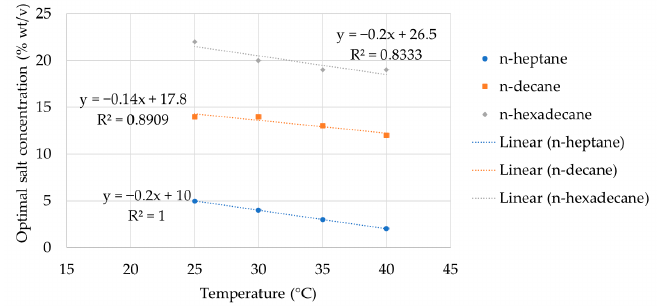
Figure 2. Optimal salt concentrations (S*) of 1% wt/v